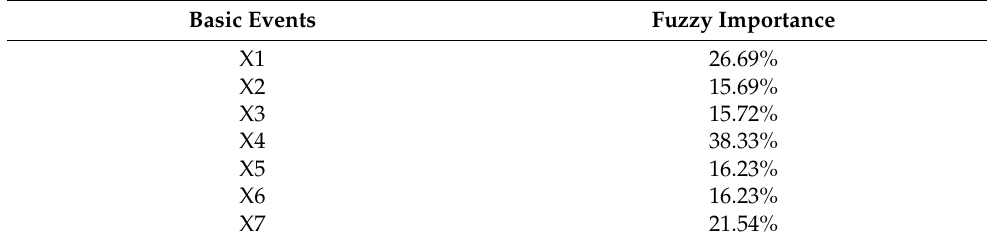
Table 11. Importance of events without information